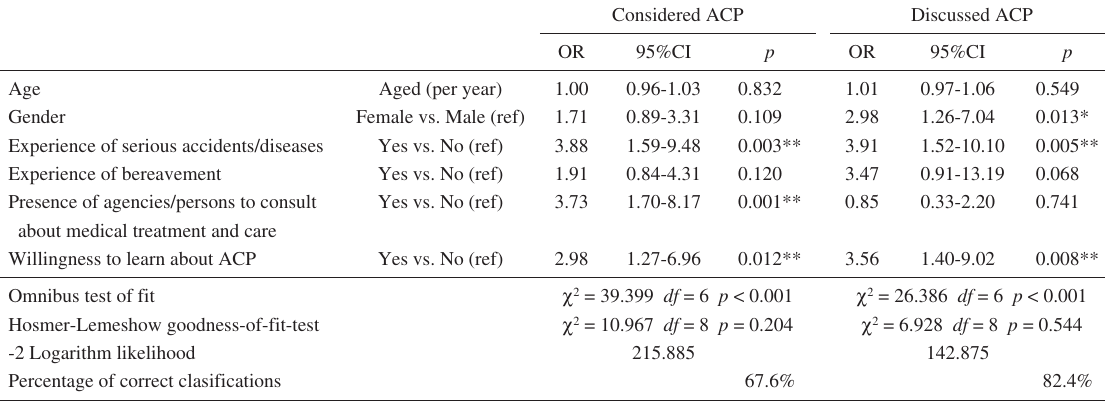
Table 4. Factors associated with the practice of advance care planning (ACP) (n =